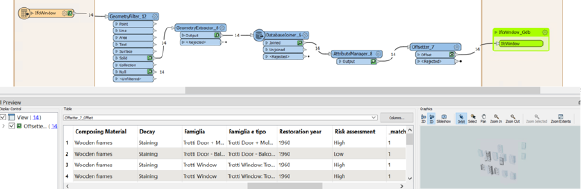
Figure 6 . IfcWindow IFC-to-shapefile conversion, with semantic and geometric